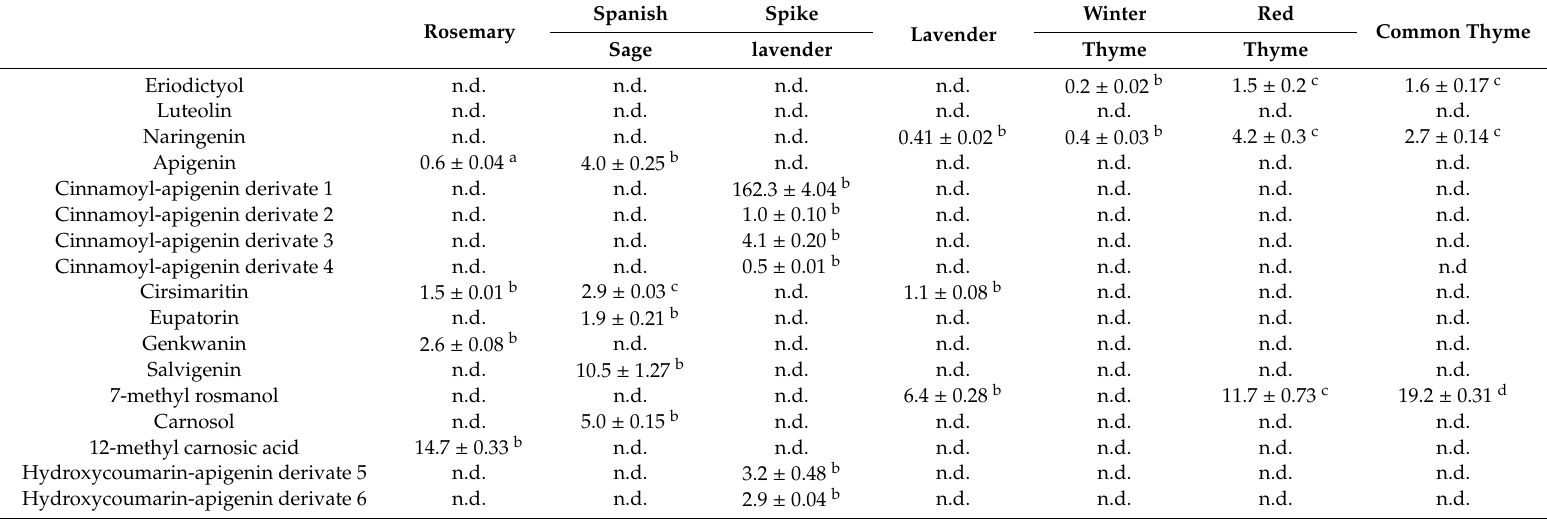
Table 4. Major polyphenolic compounds quantified in the Lamiaceae seed oils (mg / 100 g of oil). Spike Winter Red Rosemary Common Thyme Lavender Sage lavender Thyme